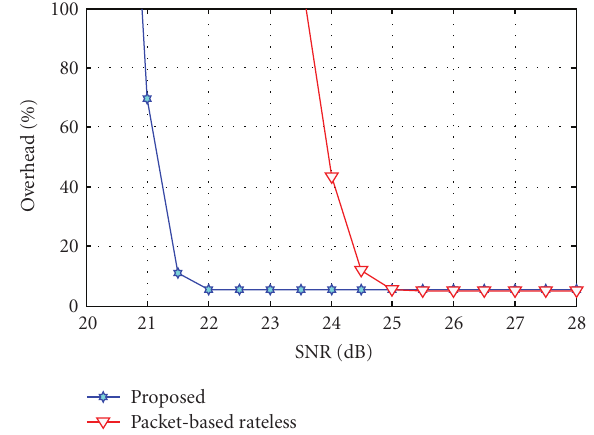
Figure 11: Overhead with block-based and simple packet-based rateless coding in a Rayleigh channel with varying